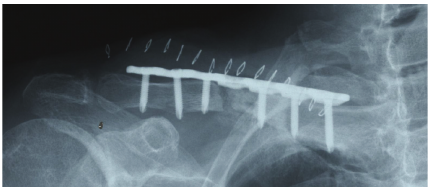
Figure 4: Postoperative radiograph demonstrating fracture fixation with 7-hole locking plate supplemented with autologous bone grafting.